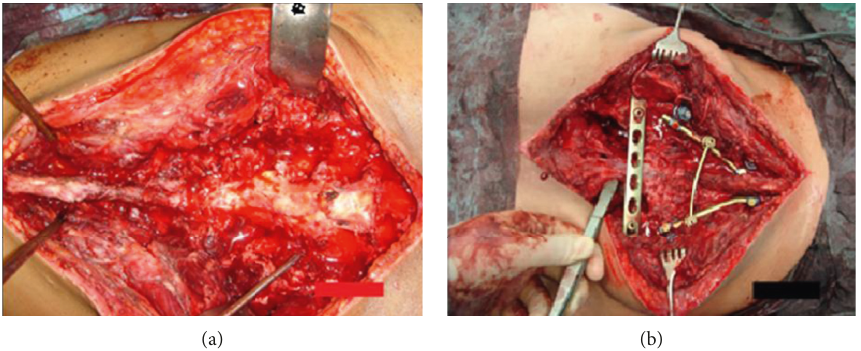
Figure 2: (a) Operative findings on the left; (b) on the right, there is the USS as well as the ilioiliac LCP